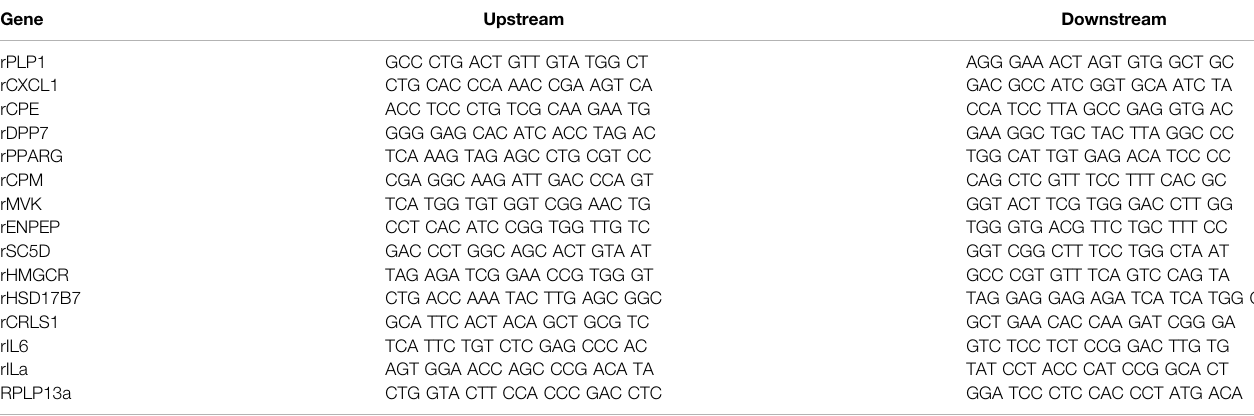
TABLE 1 | List of primers used in the study. Gene Upstream